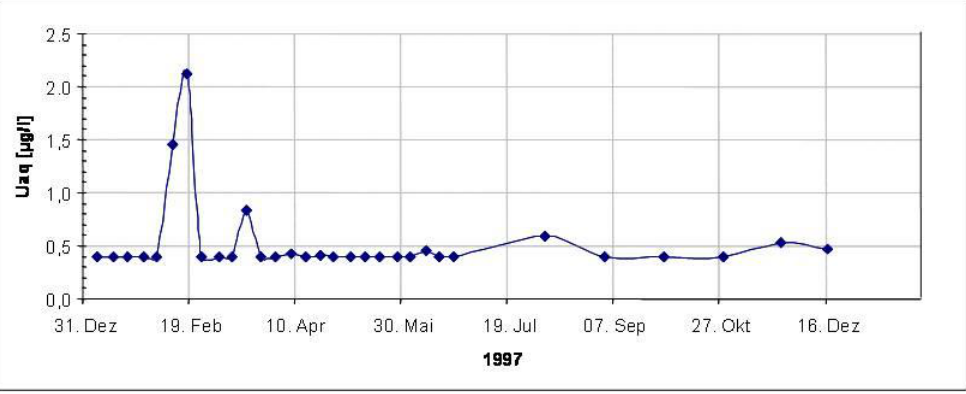
Figure 6. U concentration at the GMB eye between January and December, 1997 (data: [1]) indicating sporadic peaks at otherwise low (natural background concentration) U